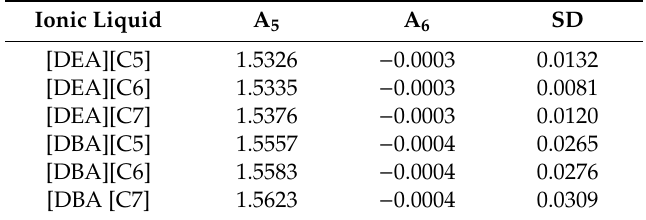
Table 4. Fitting parameters of Equation (3) to correlate refractive index ( n D ) of PILs and calculated standard deviation (SD).